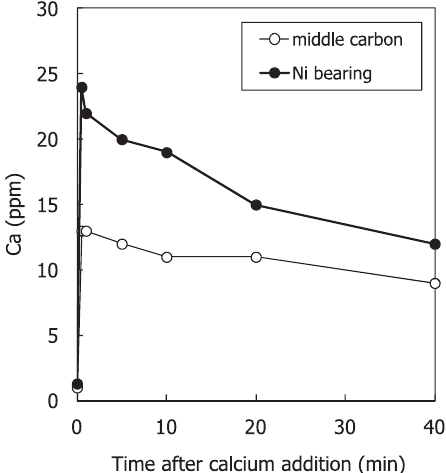
Fig. 2: Change in calcium concentration after calcium